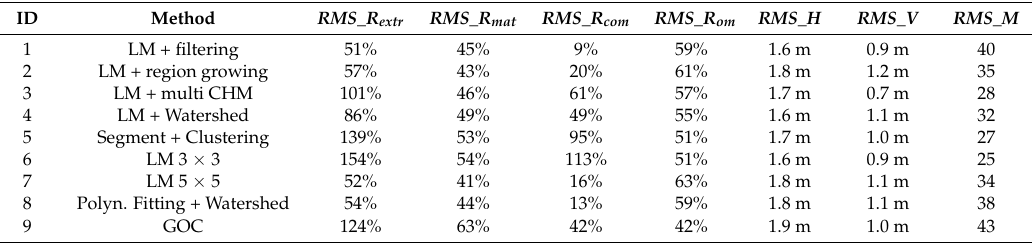
Table 6. Matching results of single-tree detection methods. Our single-tree detection method with 4-N N GOC achieves a maximum RMS_M over the dataset.